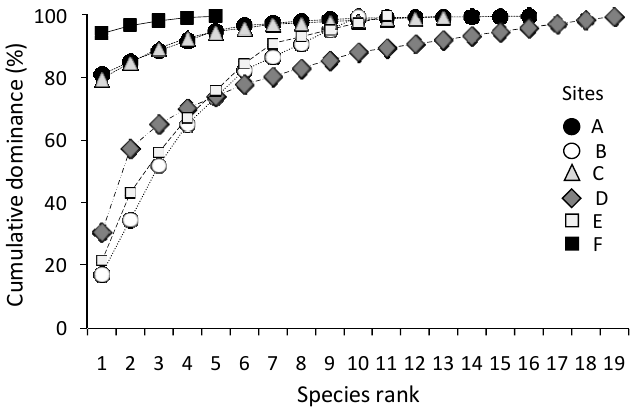
Figure 7. Cumulative dominance curves on macrobenthic abundance data from each sampling site.